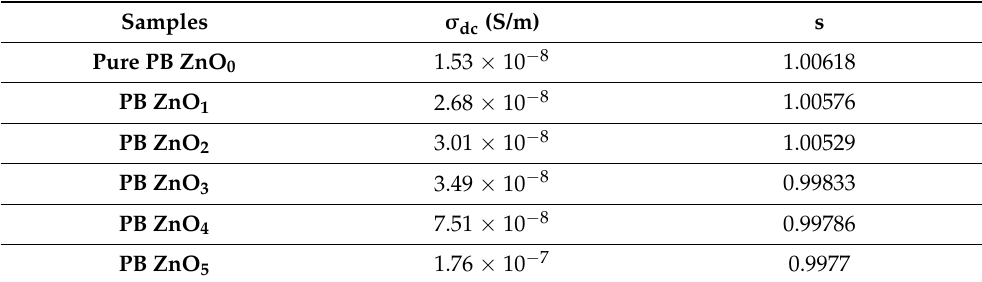
Table 5. Values of DC electrical conductivity σ dc determined from the lower frequency fit of σ ac spectra to the power law and their corresponding fractional exponent s.